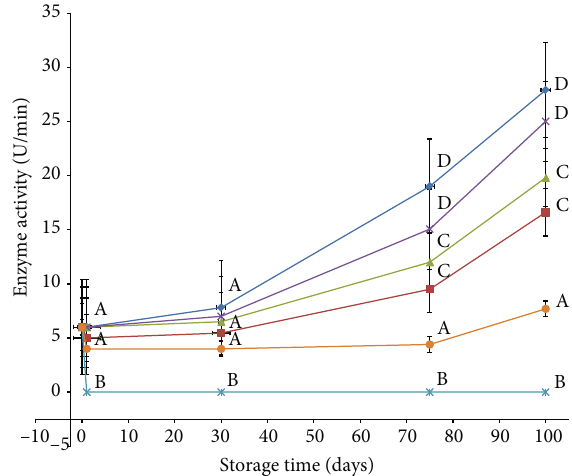
Figure 2: E ff ect of di ff erent preservation methods on peroxidase activity during storage. Control ( ♦ ), SO ( ● ), cold storage ( ▲ ), 2 blanching three minutes ( ■ ), modi fi ed atmosphere packaging ( ╳ ), and blanching ten minutes ( ∗ ). Same letter indicates no statistical di ff erences between